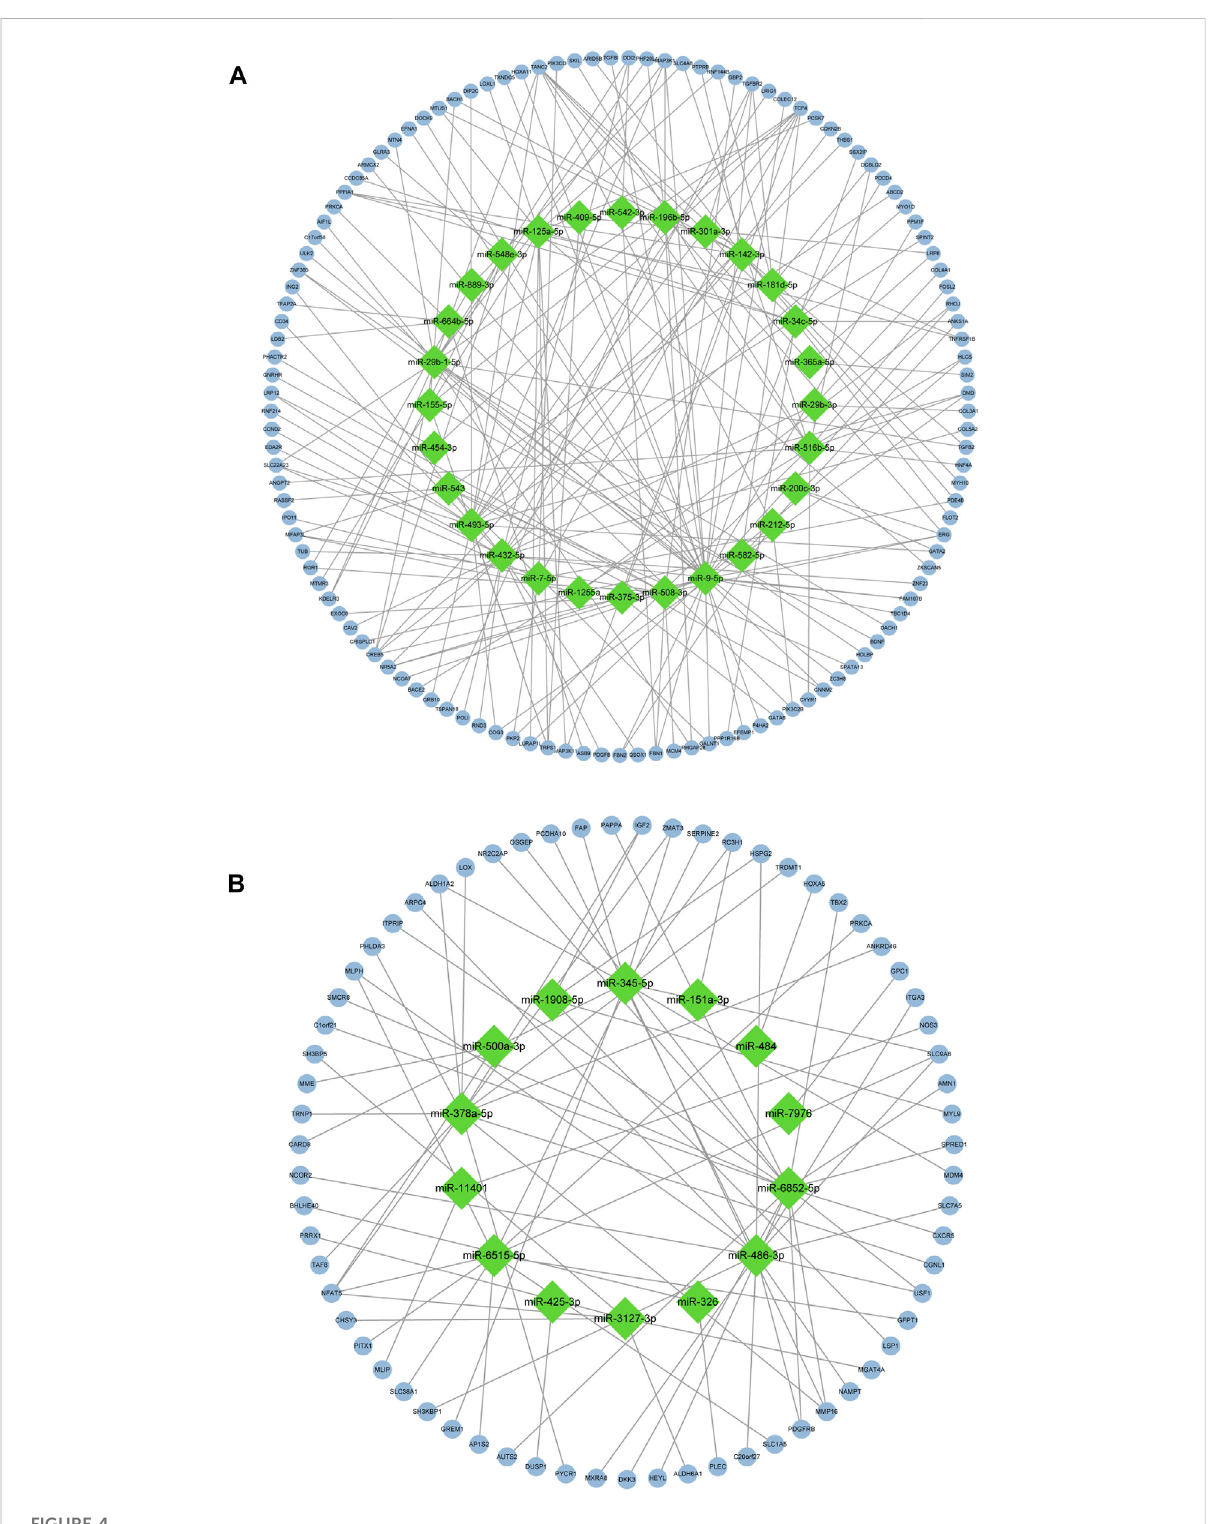
FIGURE 4 Regulatory network graph. (A) : 28 low-expression miRNAs and their target genes. (B) : 14 high-expression miRNAs and their target